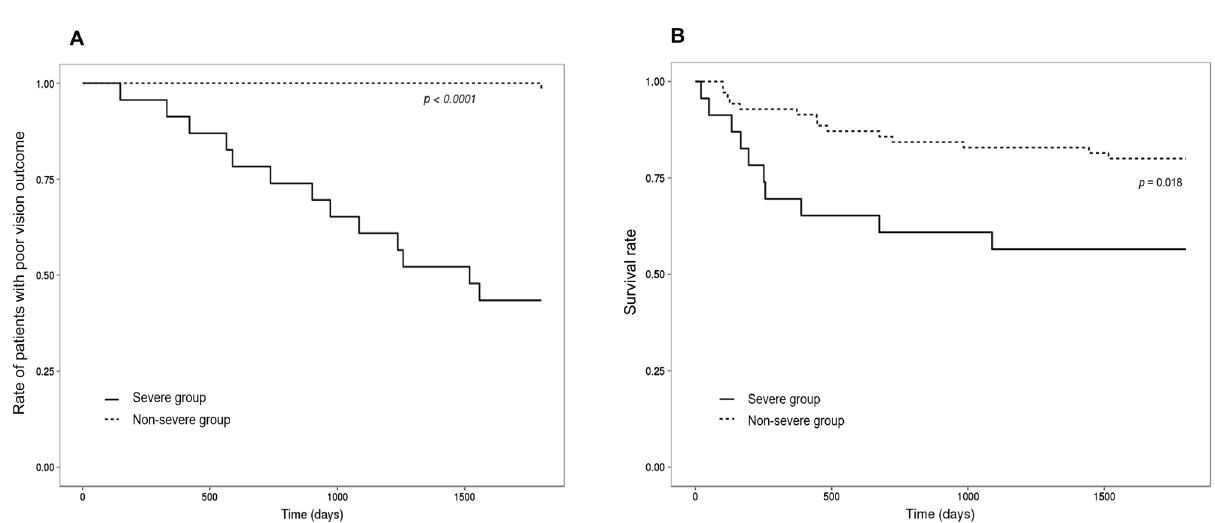
Figure 2. Five-year Kaplan–Meier survival curves of 94 patients with chronic ocular graft-versus-host disease (GVHD) for ( A ) poor vision outcomes and ( B ) overall survival according to the severe and non-severe